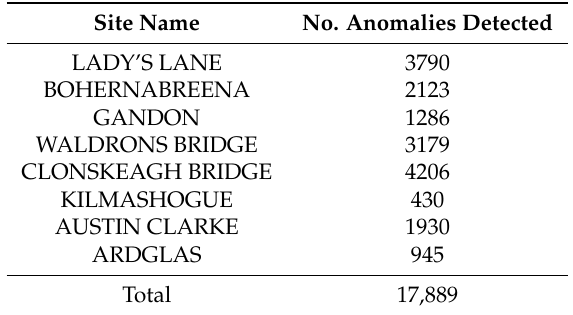
Table 5. Total number of anomalies detected using MoPBAS.